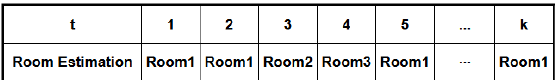
Figure 5. Each time moment the algorithm estimates the possible room.